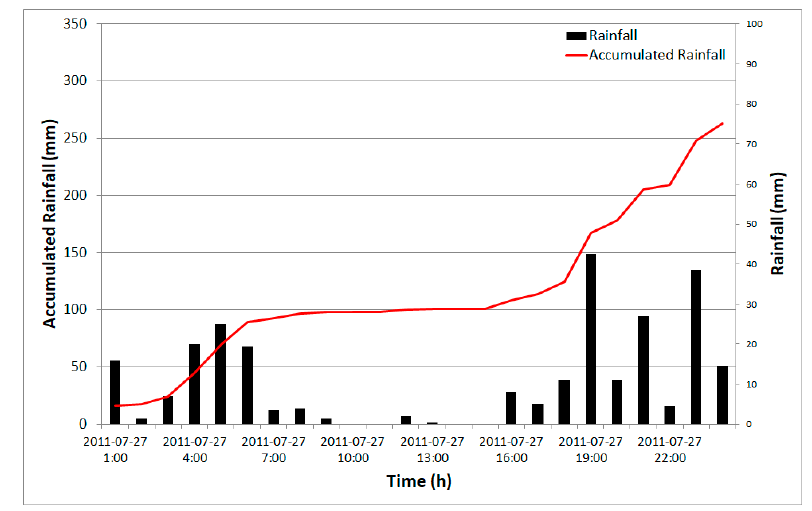
Figure 17. Hyetograph (Case 2).